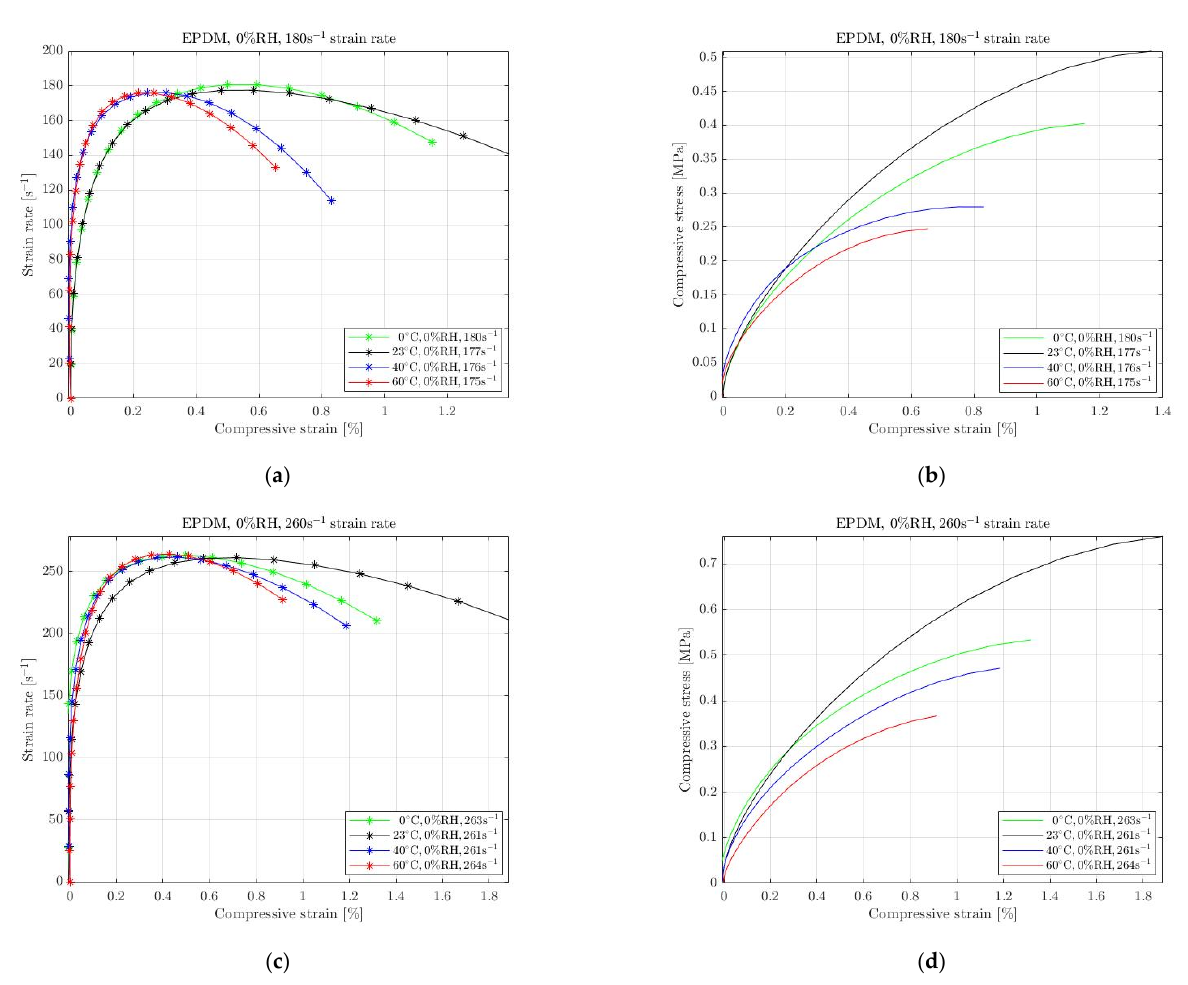
Figure 7. Strain rate vs. compressive strain ( a , c ) and compressive stress vs. compressive strain ( b , d ) of EPDM at 0 °C, 23 °C, 40 °C and 60 °C temperature with 0% RH for 180 s − 1 ( a , b ) and 260 s − 1 ( c , d ) strain rate.